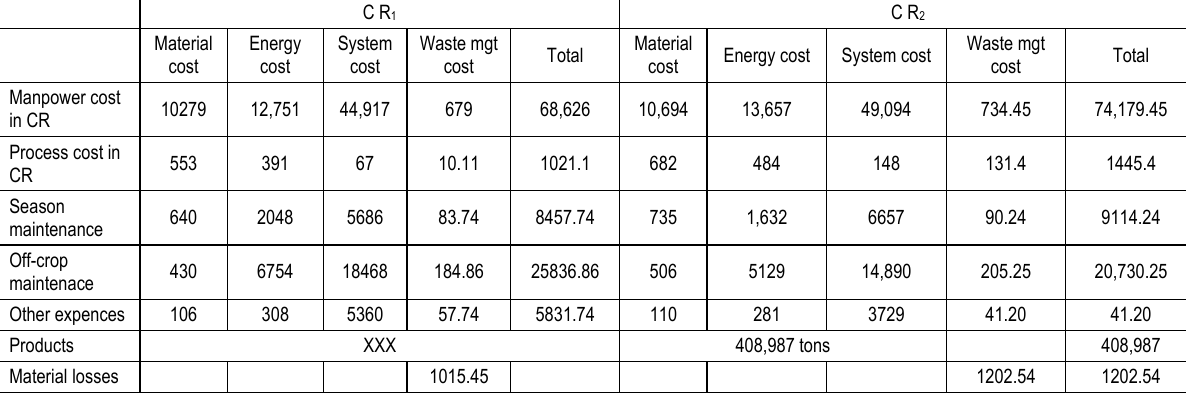
Table 2. Cost report from south milling industry for the year 2015-2016 and 2016-2017